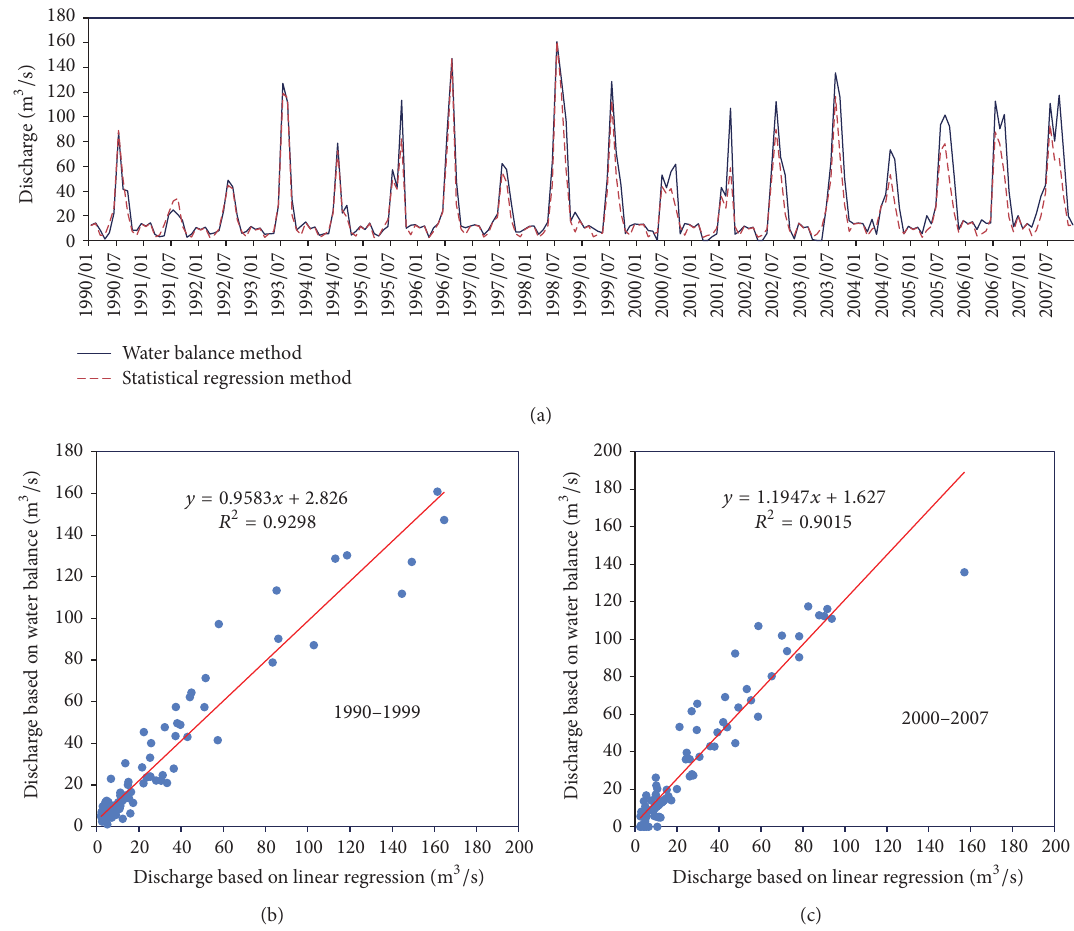
Figure 4: 1990–2007 estimated discharge at the Caotanzhuang (a) and correlations between the results by regression and water balance method, respectively (b-c).